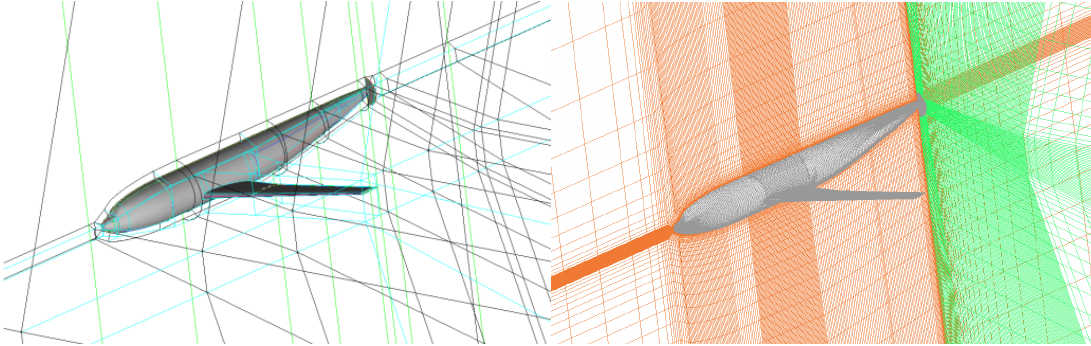
Figure 7. Unstructured mesh ( top left: general view of mesh; top right: prism mesh over body surface; bottom: global view of mesh).